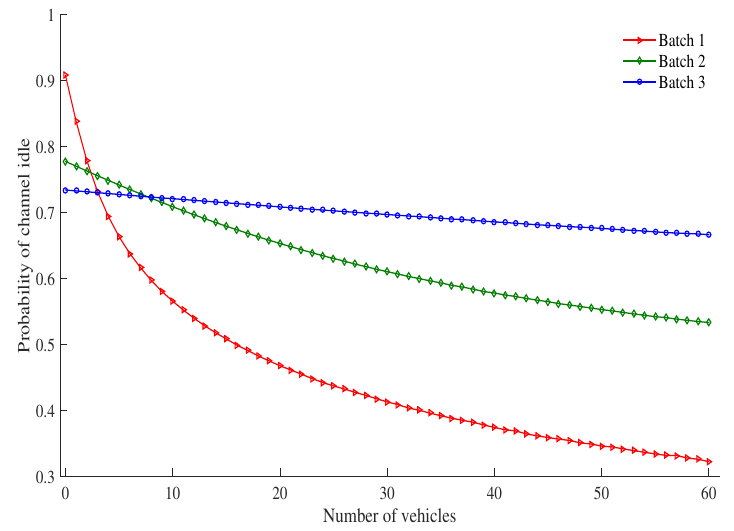
Figure 6. Probability of channel idle vs. number of